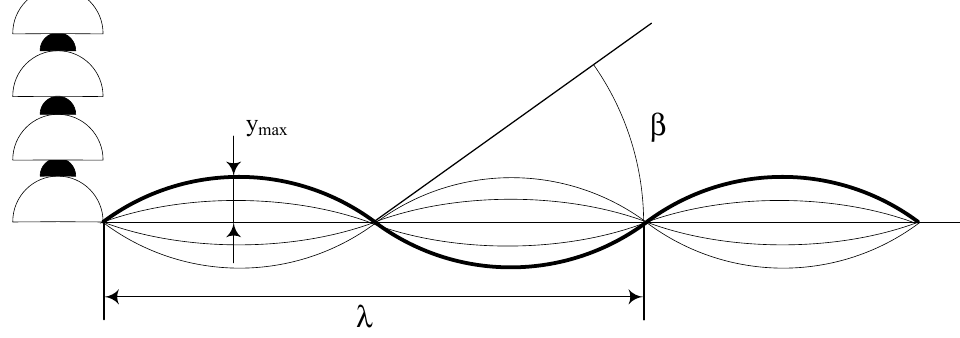
Figure 4. Schematization of some parameters useful for aeolian vibration studies.